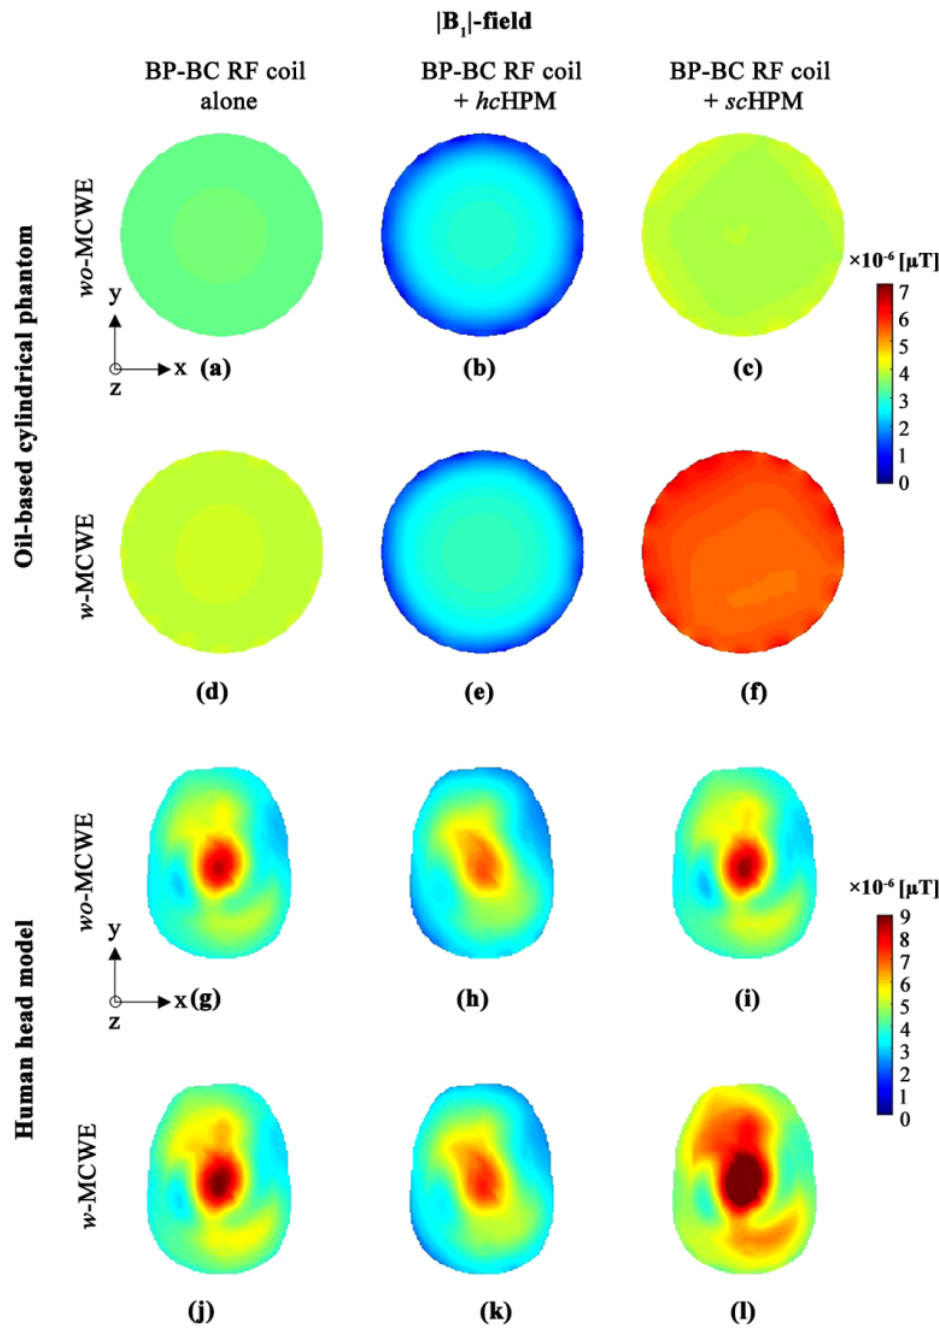
Figure 2. |B 1 |-field distribution in oil-based cylindrical phantom ( a – f ) or human body model ( g – l ): ( a , g ) BP-BC RF coil alone − wo -MCWE; ( b , h ) BP-BC RF coil + hc HPM − wo -MCWE; ( c , i ) BP-BC RF coil + sc HPM − wo -MCWE; ( d , j ) BP-BC RF coil alone − w -MCWE; ( e , k ) BP-BC RF coil + hc HPM − w -MCWE; ( f , l ) BP-BC RF coil + sc HPM − w